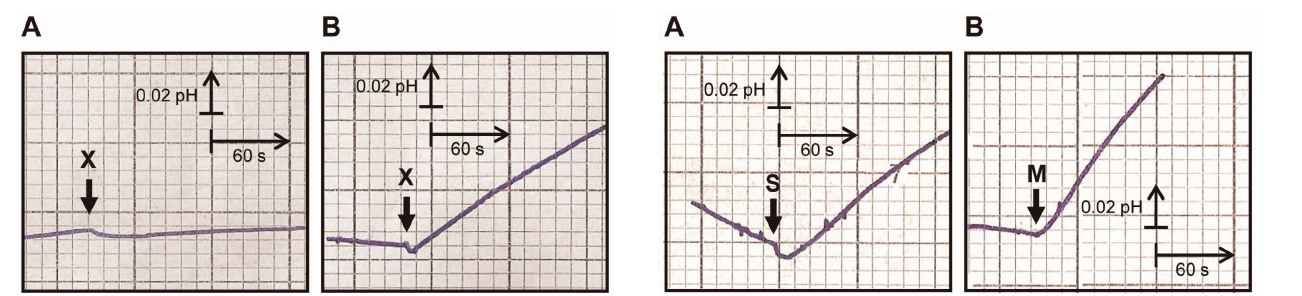
Figure 2. Symport activity in D. hansenii CBS 767 after 3 h starvation. Effect on extracellular pH elicited by addition of 10 mM D- sorbitol (S, panel A) or D-mannitol (M, panel B) to unbuffered cell suspensions (pH 5, 1 M KCl) of D. hansenii CBS 767, grown on YNB with 2% xylitol, after 3 h starvation. The arrows indicate the times of polyol addition. Data are representative of at least two independent